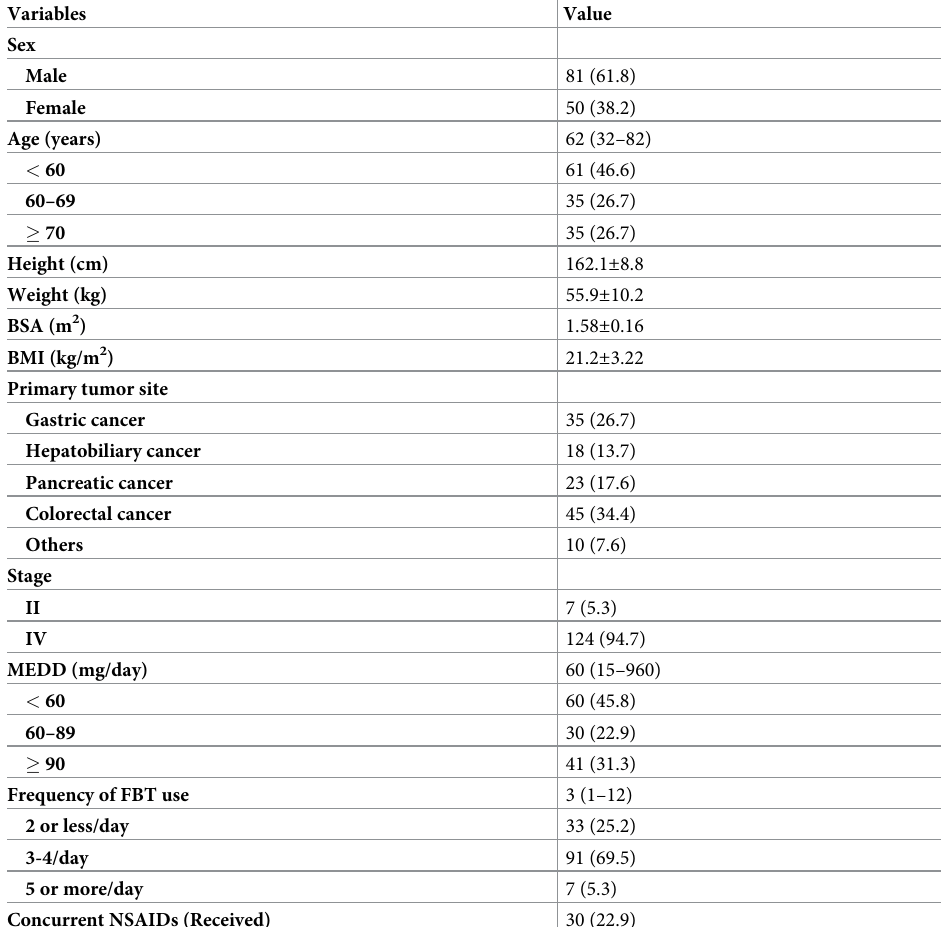
Table 1. Patient characteristics (n =